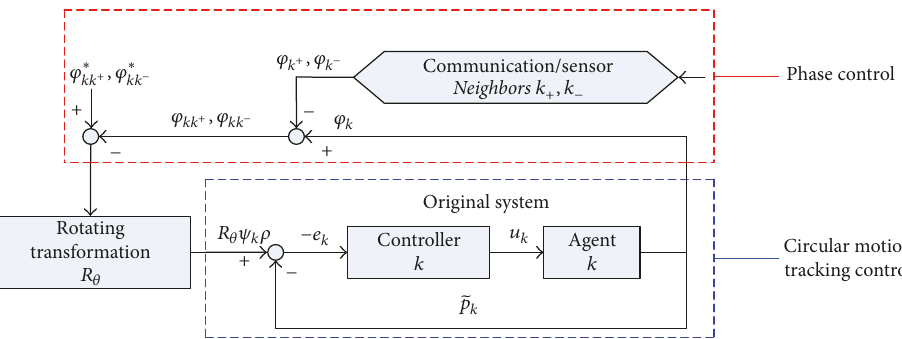
Figure 2: Feedback control design scheme of circular formation.